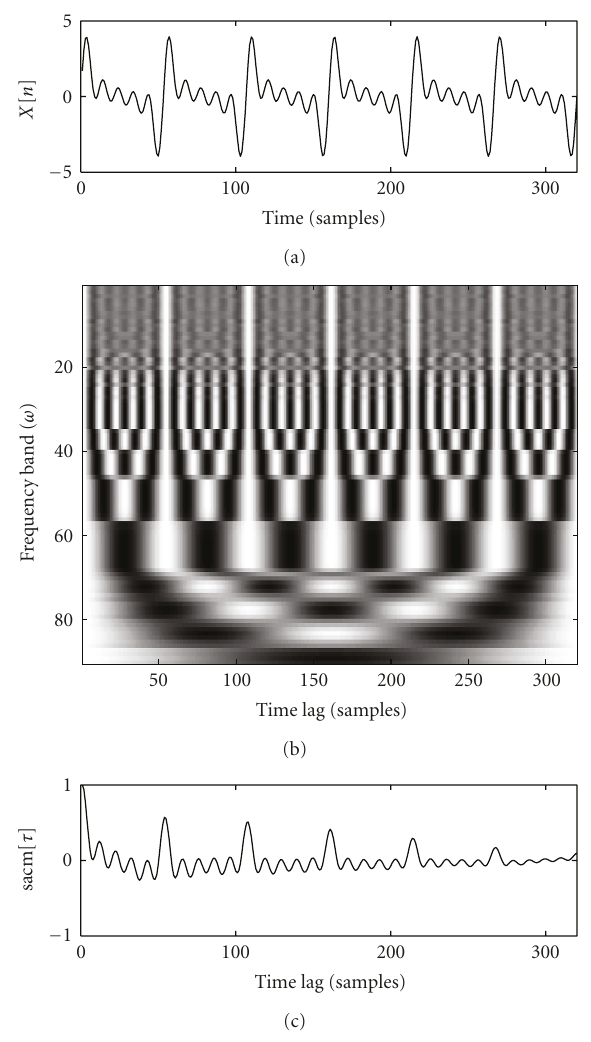
Figure 4: Autocorrelogram representation of a sum of